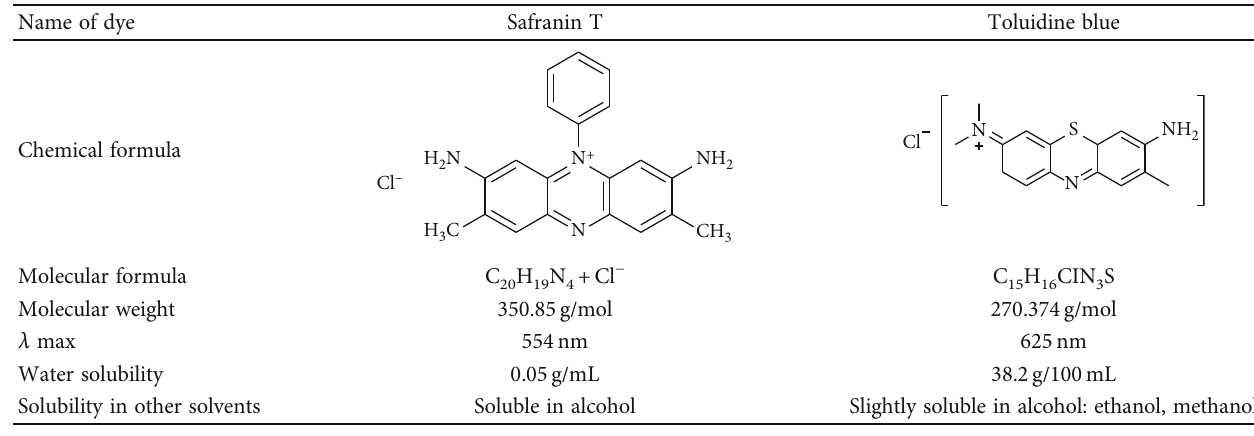
Table 1: Physiochemical properties of safranin and toluidine dyes [48,